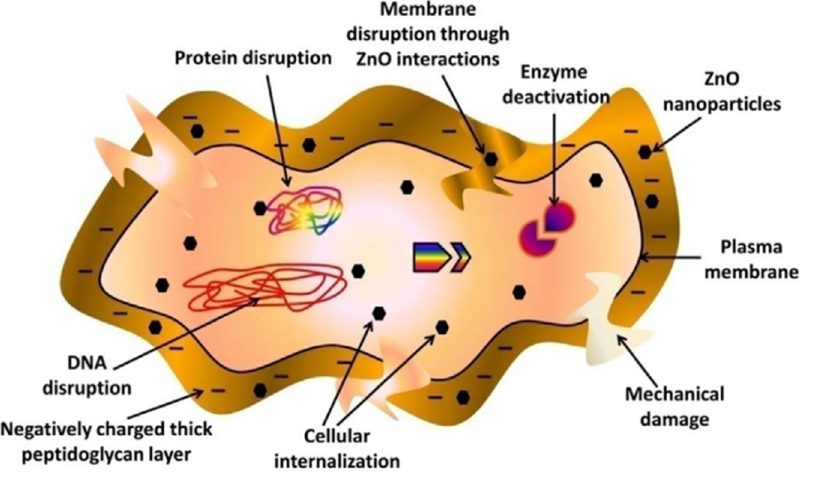
Figure 13. Schematic diagram of the physical action of ZnO nanomaterials for sterilization. Reprinted/adapted with permission from Ref. [27]. Copyright© 2022, Elsevier B.V.